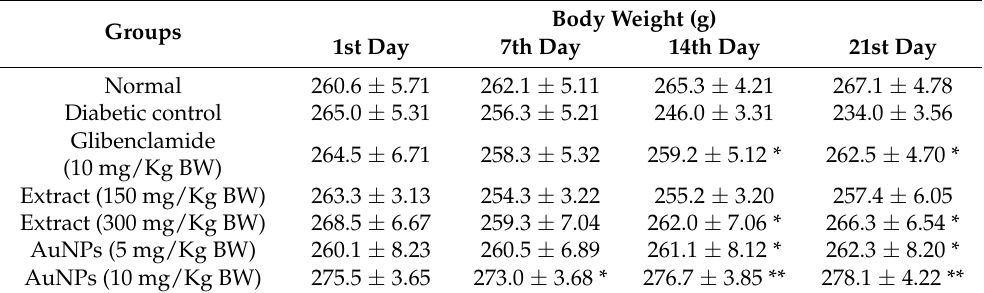
Table 8. Consequences on body weight of diabetic rats of a methanol extract and AuNPs. Groups